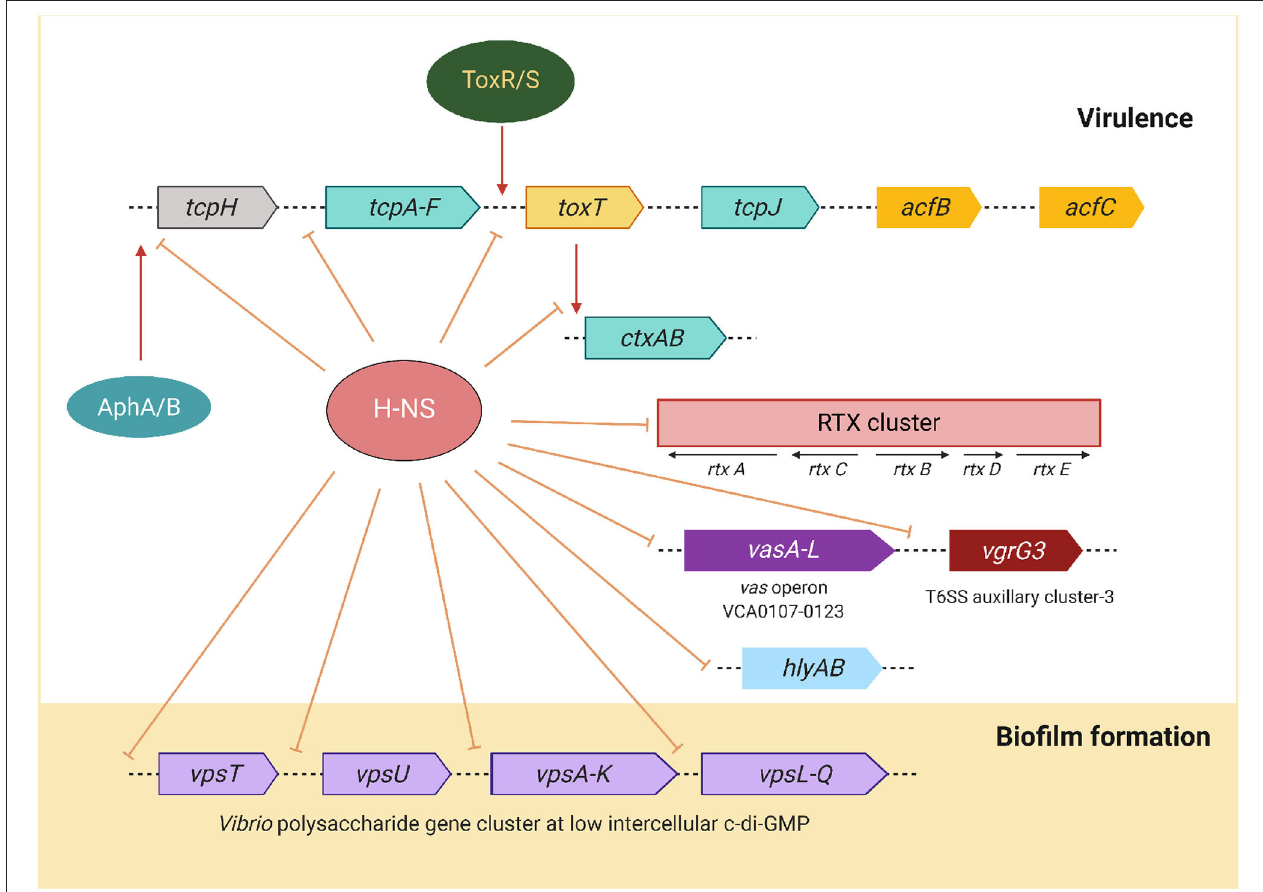
FIGURE 5 | Schematic representation of V. cholerae H-NS mediated negative modulation virulence and biofilm expression. Apart from the ctxAB operon, most of the genes are silenced by H-NS is located in the tcp , rtx gene clusters, vas T6SS operon, hlyA hemolysin/cytolysin, and the vps biofilm utilization genes at low c-di-GMP. Lines with base near the intergenic regions represent H-NS repression. Red arrow indicates activation of corresponding